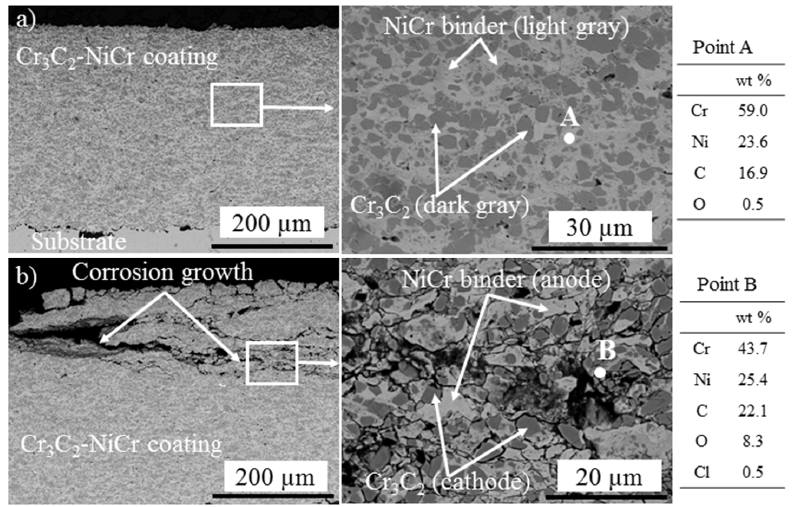
Figure 3. SEM back ‐ scattered micrograph of cross ‐ section of the ( a ) as ‐ sprayed Cr 3 C 2 ‐ NiCr coating, ( b ) corrosive ion penetration paths, cathodic and anodic sites within the Cr 3 C 2 ‐ NiCr coating after salt ‐ spray test at 24 °C for 240 h, and the corresponding EDS point analysis.